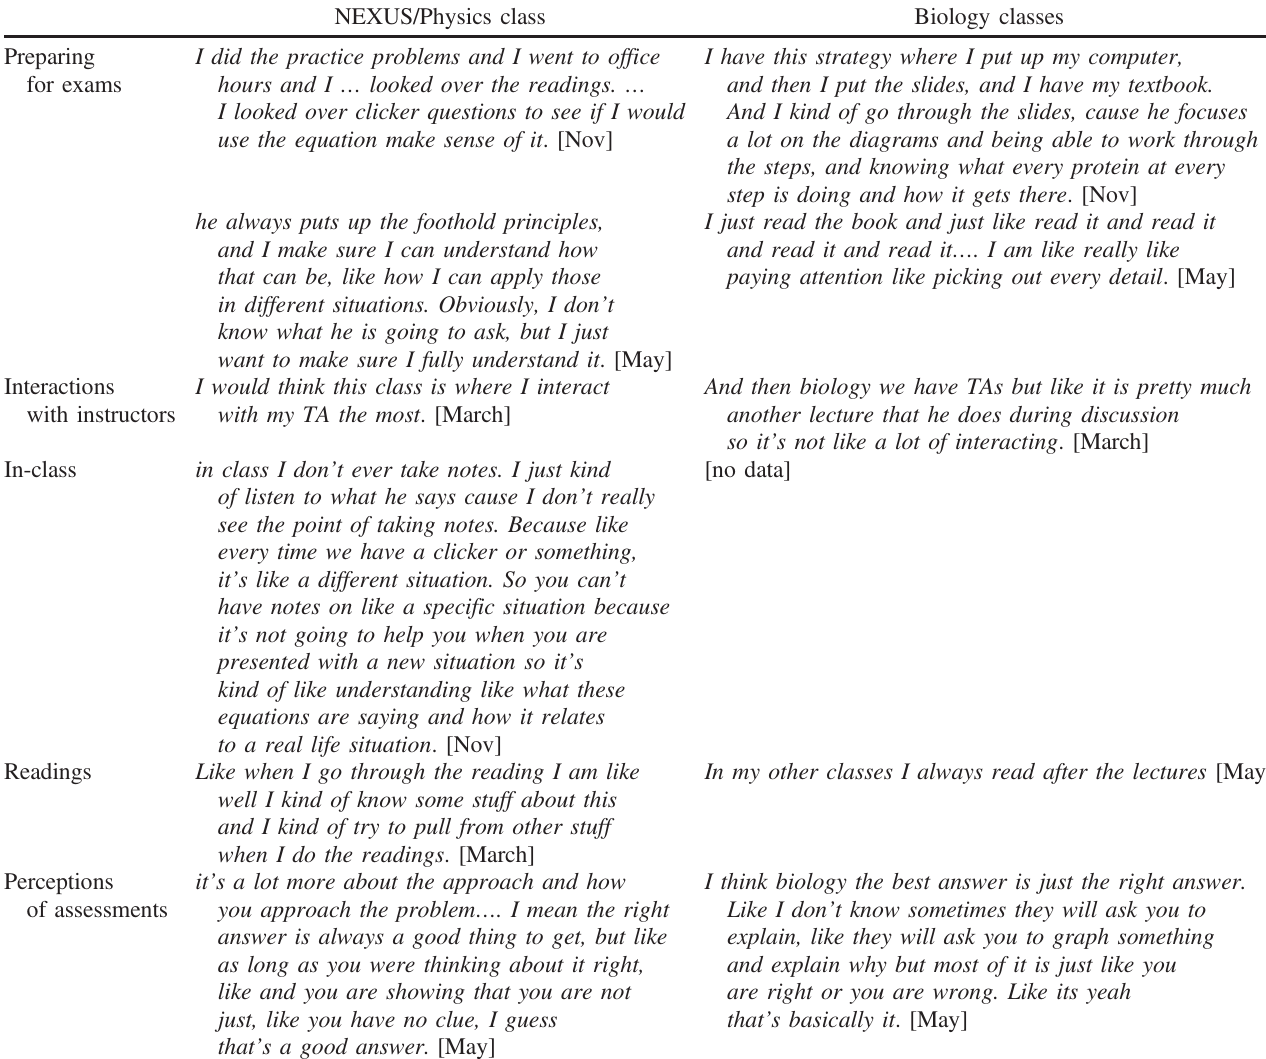
TABLE III. Phillip ’ s approach to learning in his physics and biology classes.